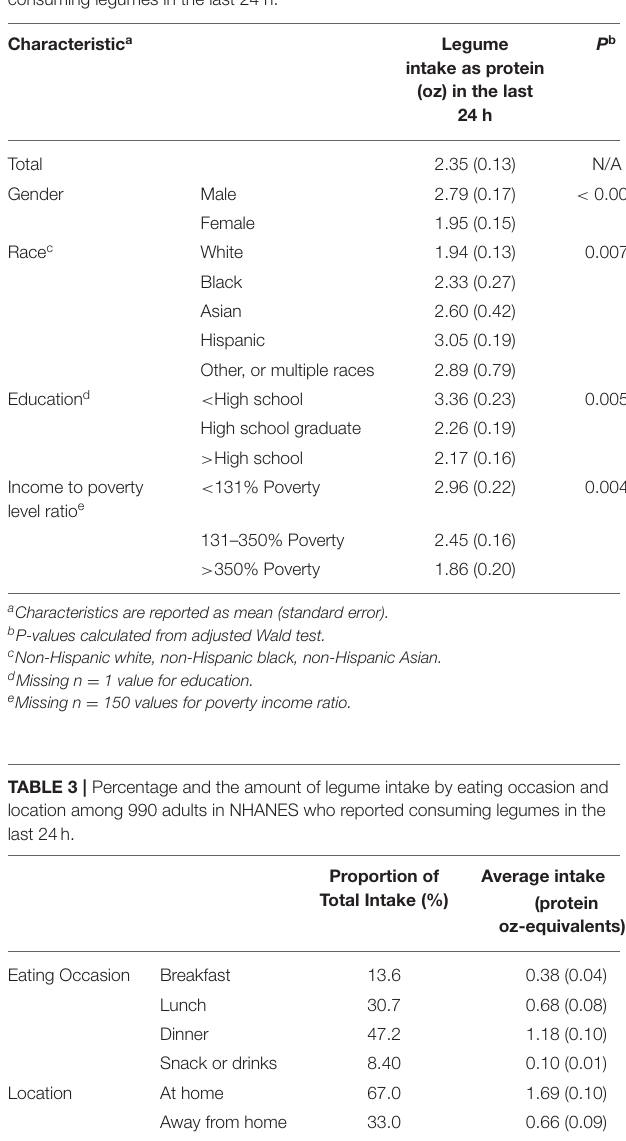
intake as protein